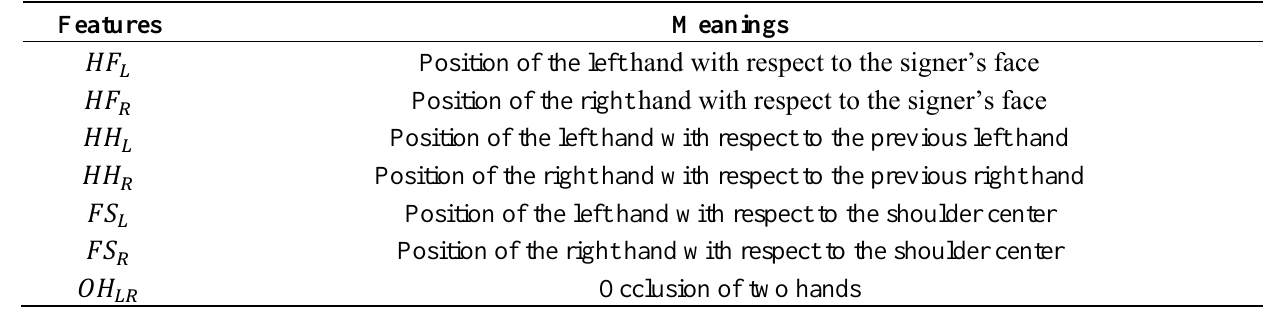
Table 1. Seven features for recognizing the signer’s